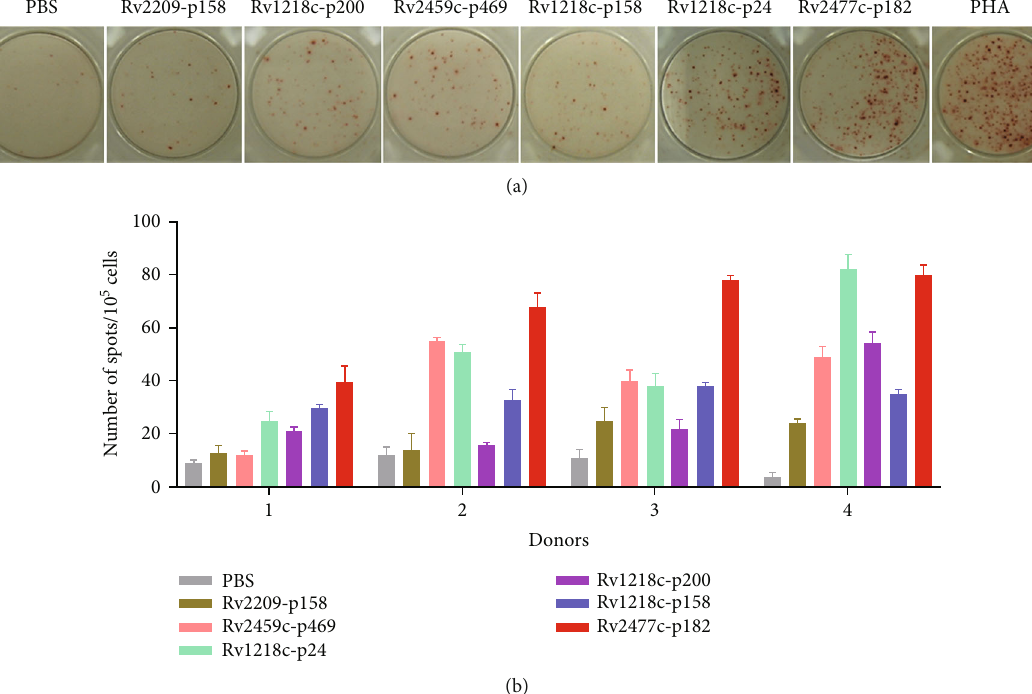
Figure 2: IFN- γ secretion of peptide-induced CTLs was determined with ELISPOT assay. Candidate peptides were used to induce CTLs with peptide-loaded DCs from four healthy PPD + donors in vitro . T cells were stimulated three times at weekly intervals, and rhIL-2 (50 U/mL) and rhIL-7 (10 ng/mL) were added at intervals of 2 days. On day 21, the induced T cells were collected to measure IFN- γ secretion with an ELISPOT assay. (a) Typical chart for each group. (b) Statistical analysis of each peptide in four donors ( n = 4 ). Peptide-loaded T2A2 cells or T2A2 cells only were used as the stimulated cells. PBS group was the negative control; PHA was used as the positive control.